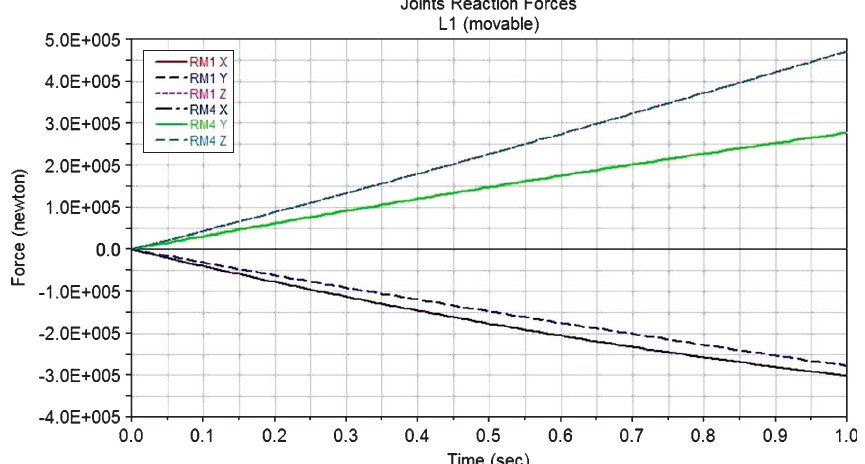
Fig. 13. Computed reaction forces at spherical joints that connects L1-A 1 , 1 and L1-A 1 , 4 .